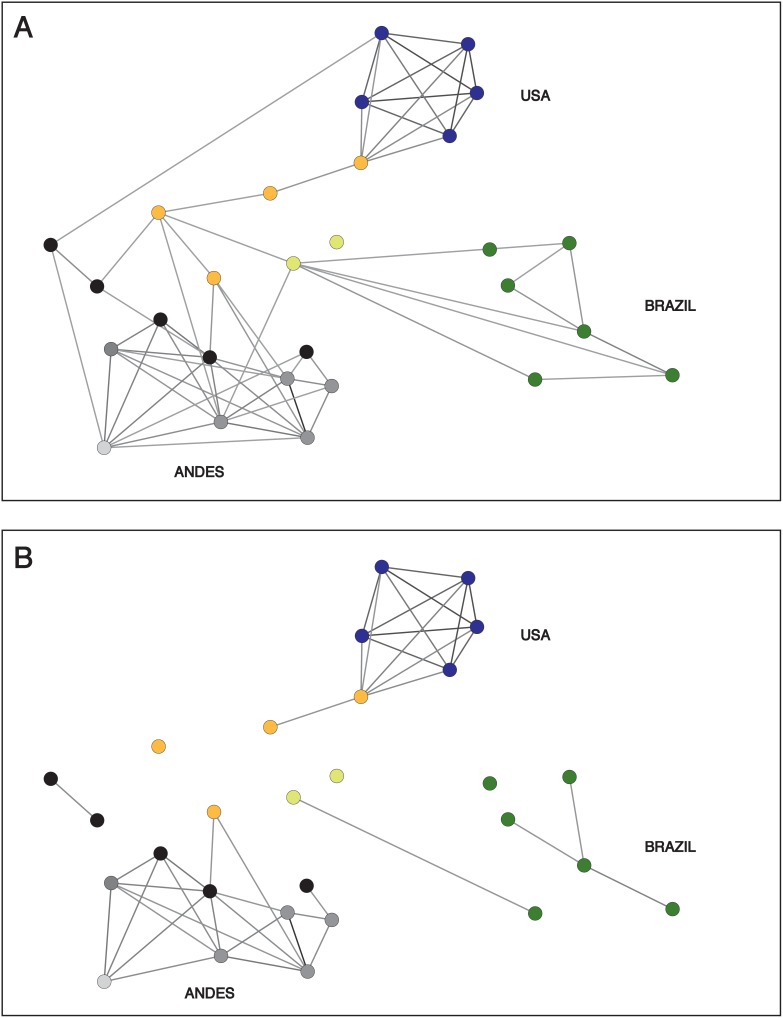
Networks of TcI genotypes characterized with microsatellite data from Lewis et al.(A) Just above percolation distance (Dp = 0.37), and (B) just below, illustrating the disconnection of the 3 clusters of nodes. According to color code, 3 geographical regions are highlighted: USA (Violet), Brazil (Green) and Andes (Peru and Argentina in Dark Grey, Chile in Light Grey, Bolivia in Black). Colombia in Orange and Venezuela in Yellow green show the intermediate position of stocks isolated in those countries, at the interface of the three clusters.